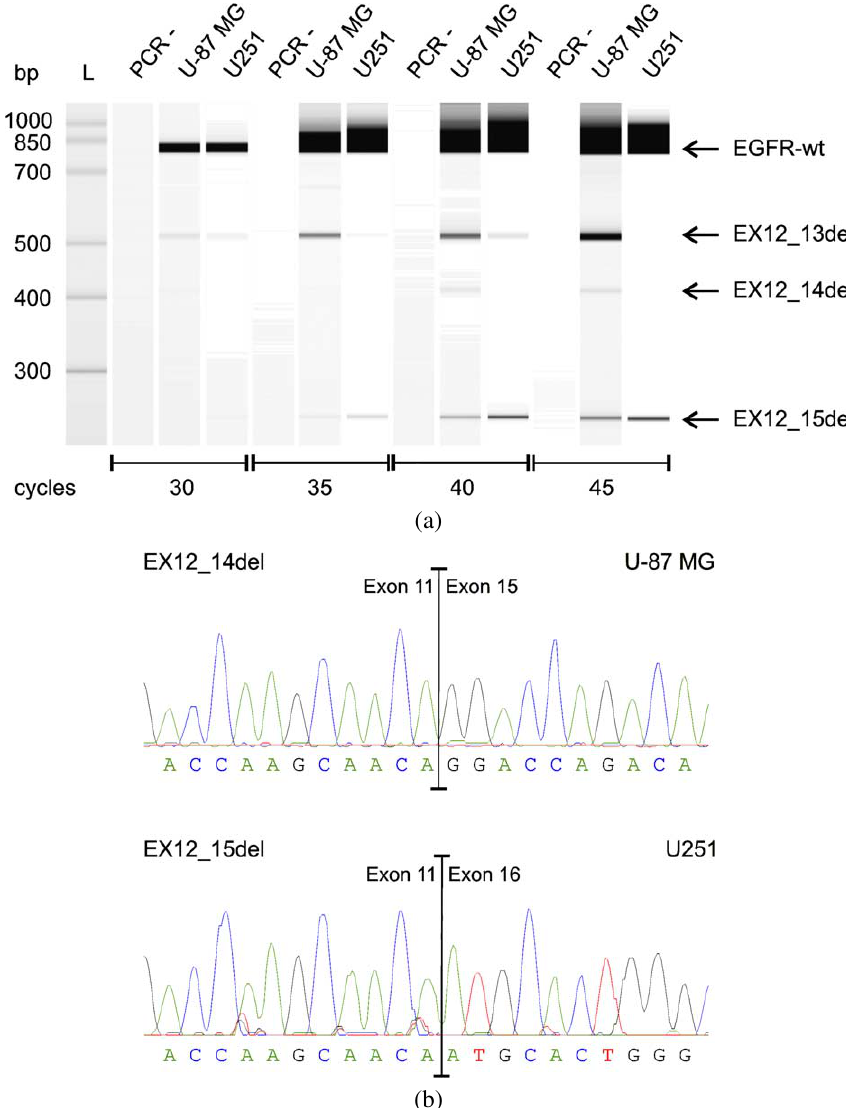
Fig. 2. Detection of EGFR variants in glioma cell lines. (a) Amplified cDNA fragments of EGFR wild-type and different variants. Fragments were analyzed by capillary electrophoresis with the Bioanalyzer 2100 (Agilent Technologies, Böblingen, Germany). bp: Base pairs, L: ladder, PCR − : negative control for PCR. (b) Partial cDNA sequences of the EGFR deletion variants in glioma cell lines showing the fusion points of different